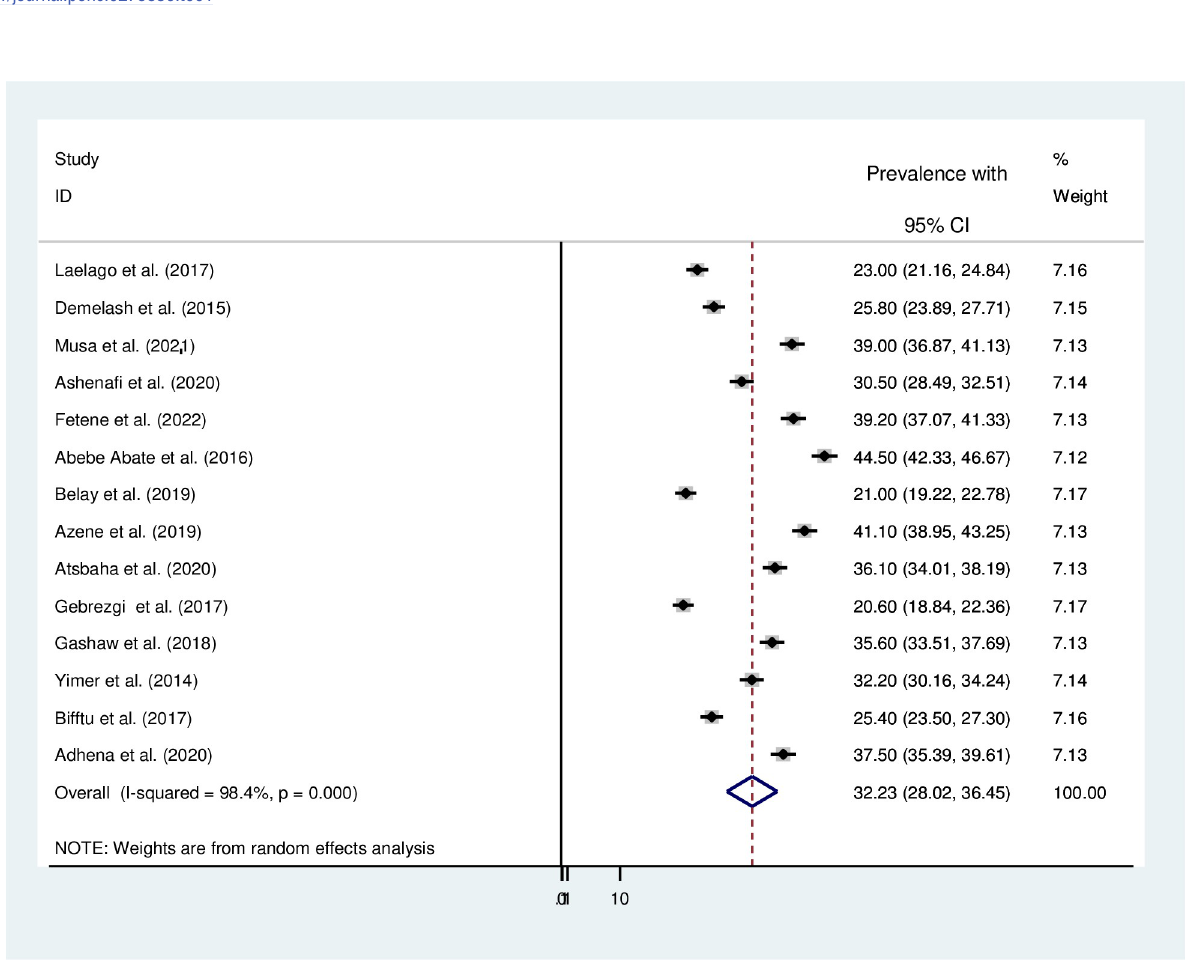
Fig 2. Forest plot for the pooled prevalence of intimate partner violence during pregnancy in